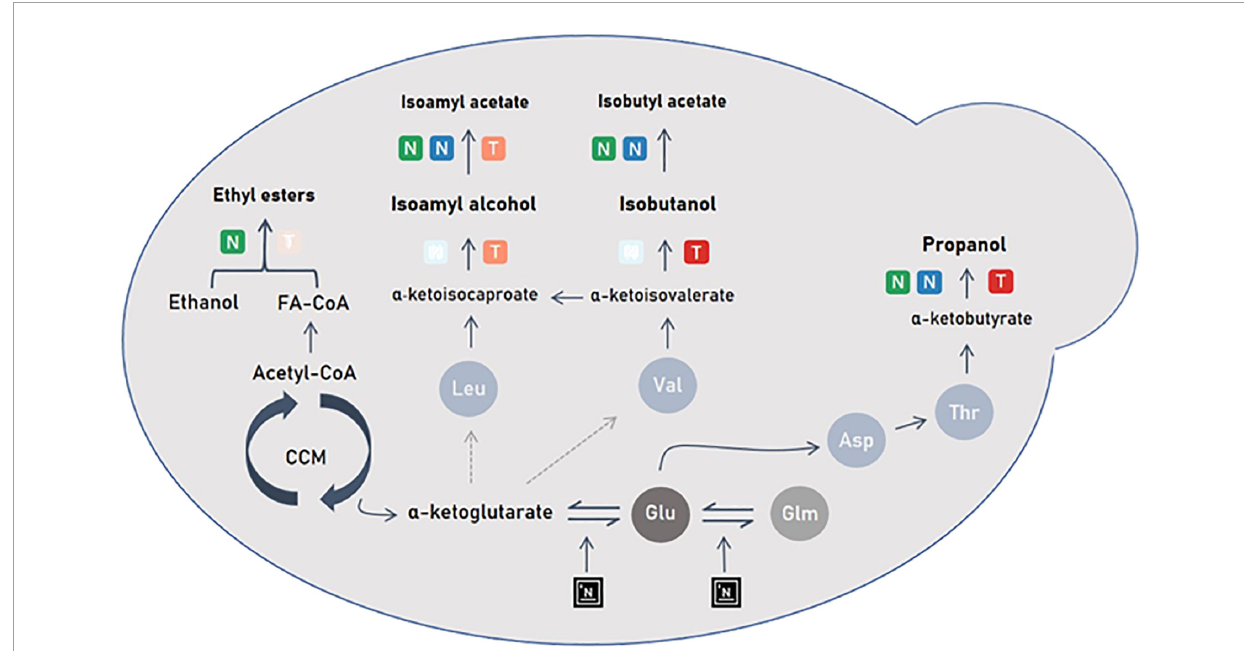
FIGURE6 Scheme representing the impact of nitrogen and temperature management on yeast metabolism. NO is represented by a green gradient; Nadd by a blue gradient; Temp by a red gradient. The added nitrogen will act at the α -ketoglutarate node and induce a change in the flow of amino acid synthesis that affects aromas